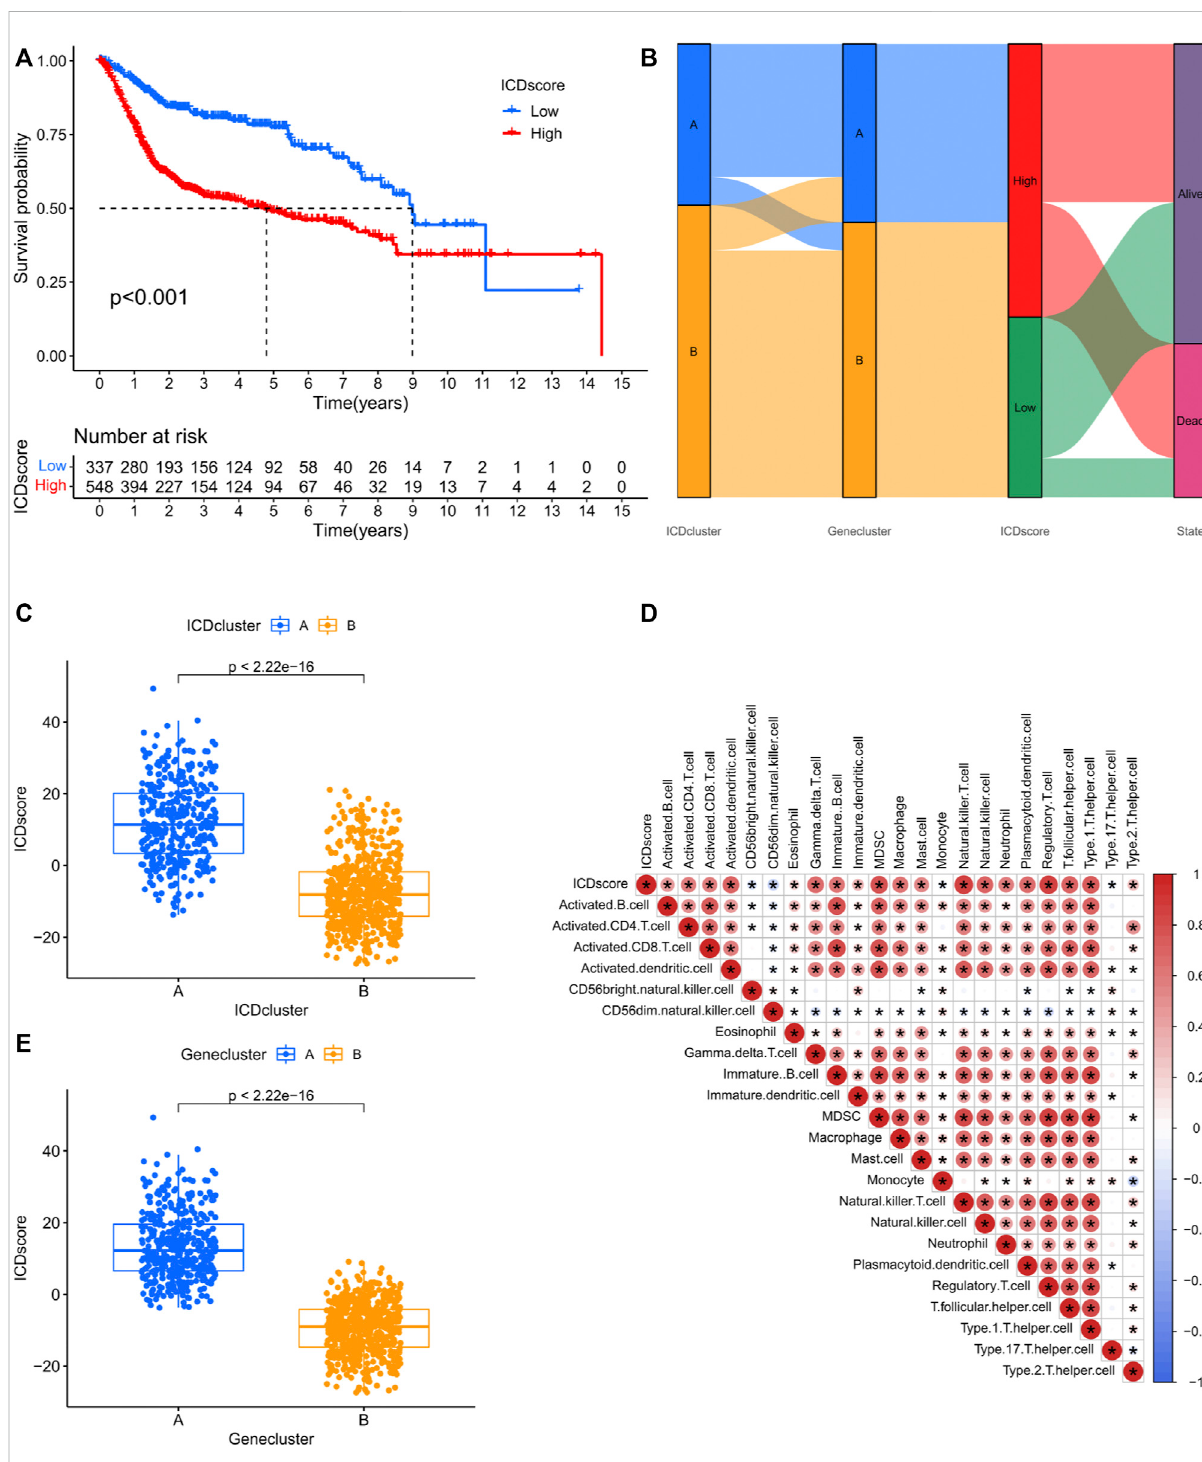
FIGURE 5 ICDscoreisaquanti fi cationindicatorofindividualsamplesinthemergedcohort. (A) Kaplan – MeiercurveanalysisofdifferentICDscoregroups. (B) Sankey diagram demonstrating correlations among ICD clusters, ICD score and ICD gene clusters. (C) Differences in ICD scores among two ICD clusters in the merged cohort. (D) Differences in ICD scores among two gene clusters in the merged cohort. (E) ssGSEA analysis showing a correlation between ICD score and the in fi ltration abundance of various immune